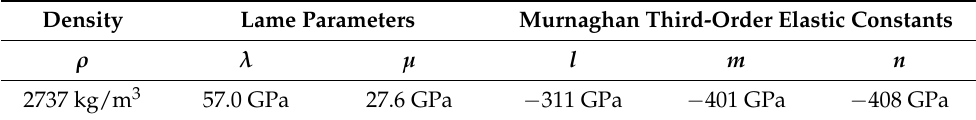
Table 1. Material properties of Al-1200 [36].